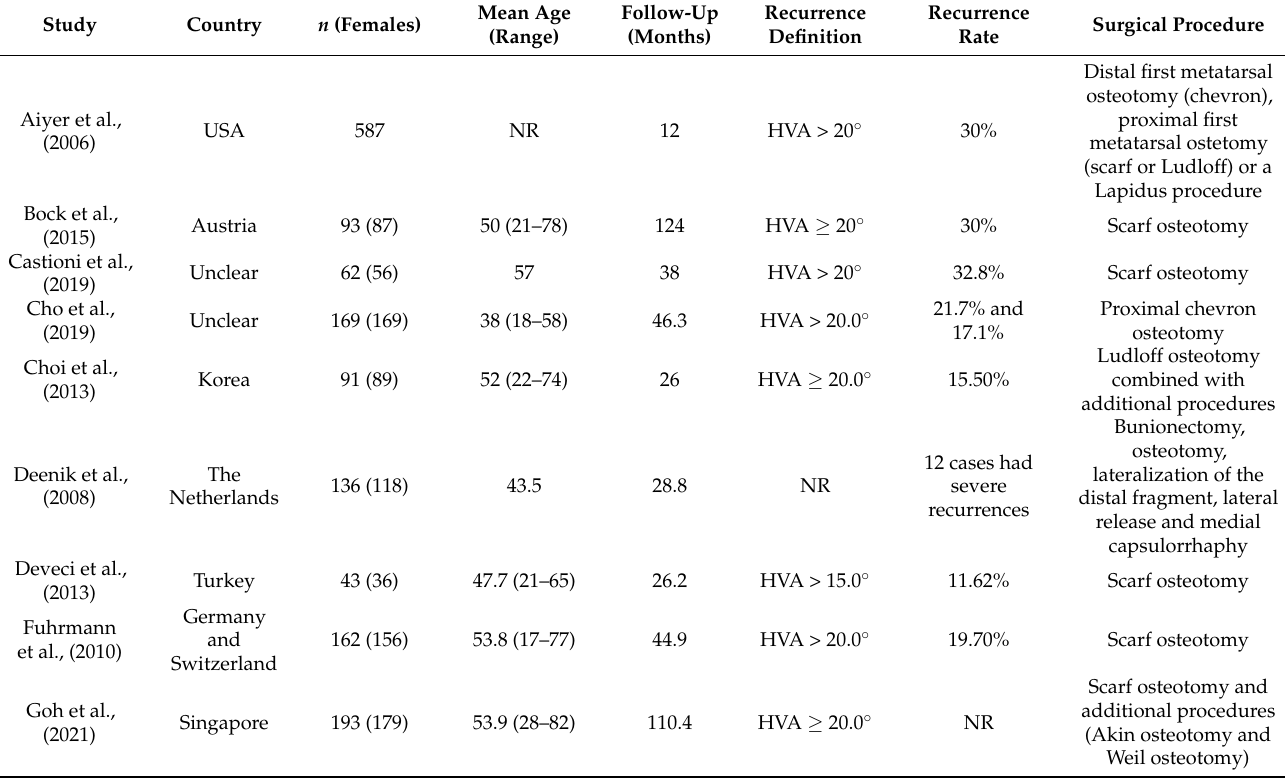
Table 1. Characteristics of the studies .